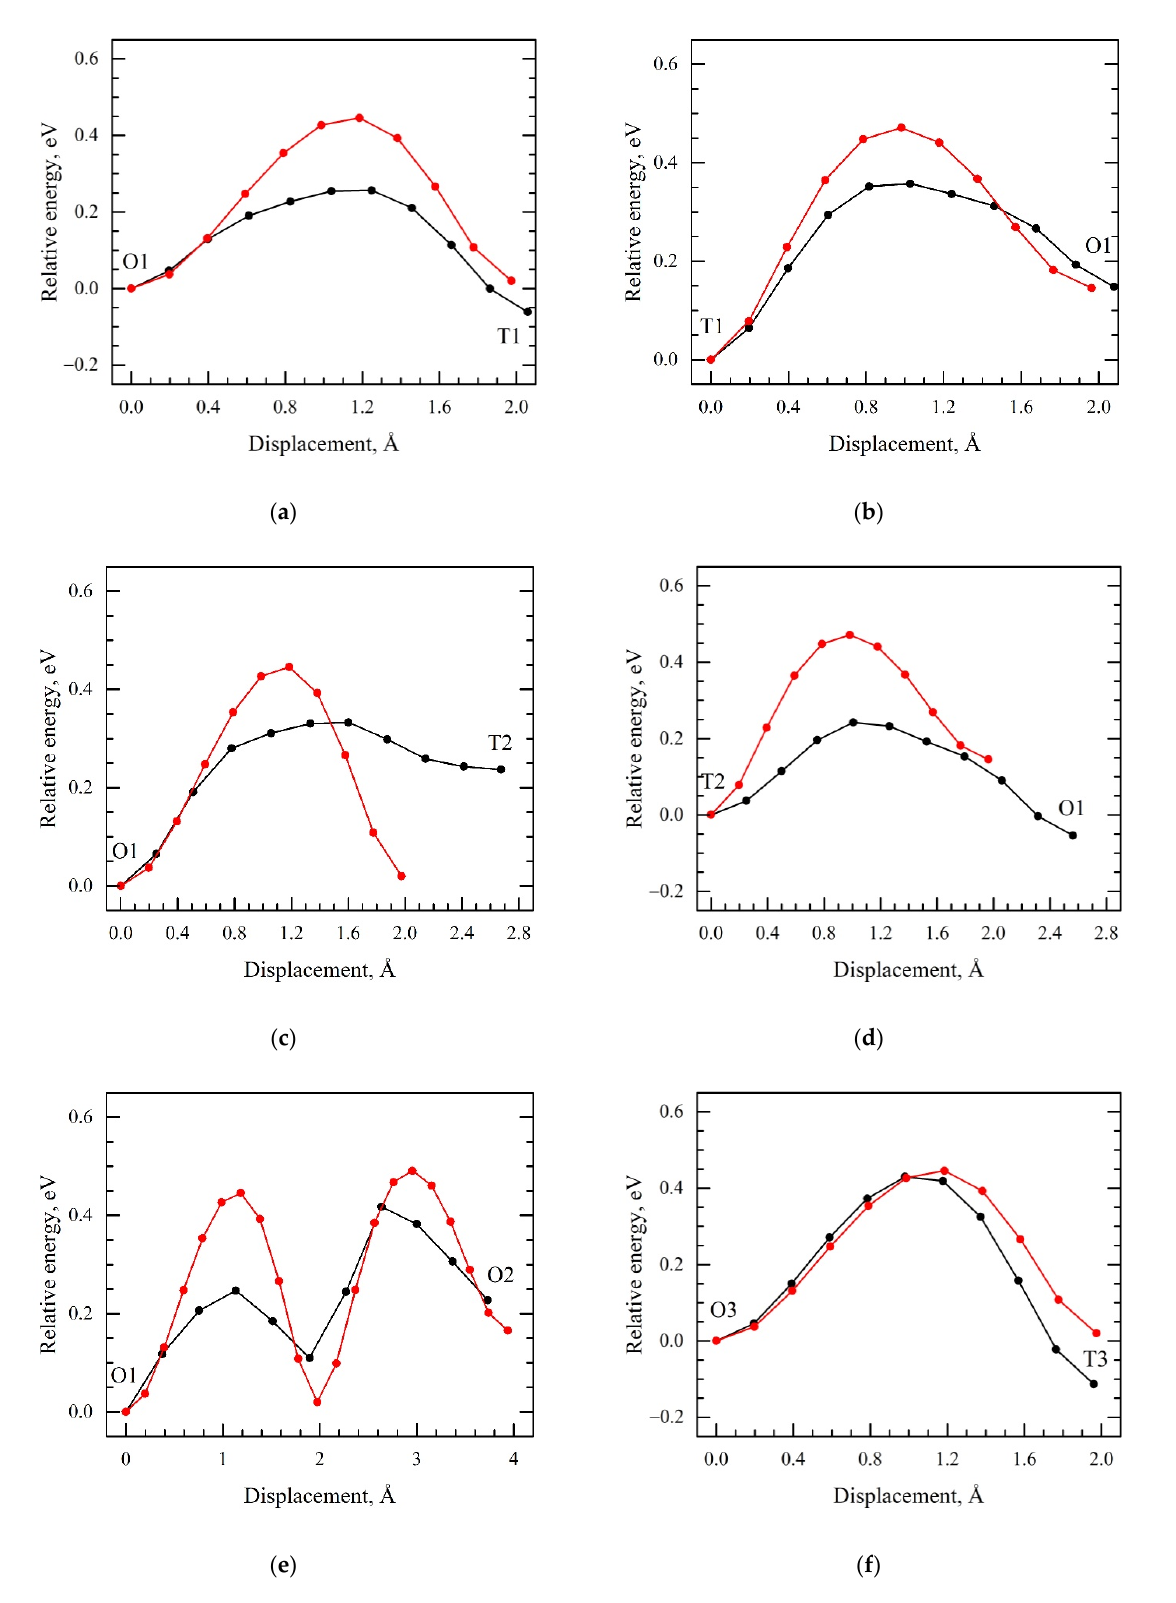
Figure 9. The minimum energy paths for a hydrogen atom along the directions of ( a ) O1-T1, ( b ) T1-O1, ( c ) O1-T2, ( d ) T2-O1, ( e ) O1-O2, and ( f ) T3-O3 in the Zr atomic layers of Zr 36 Nb 36 slab nearest to the interface (black line) and the same diffusion energy paths for hydrogen atoms in the HCP zirconium lattice (red